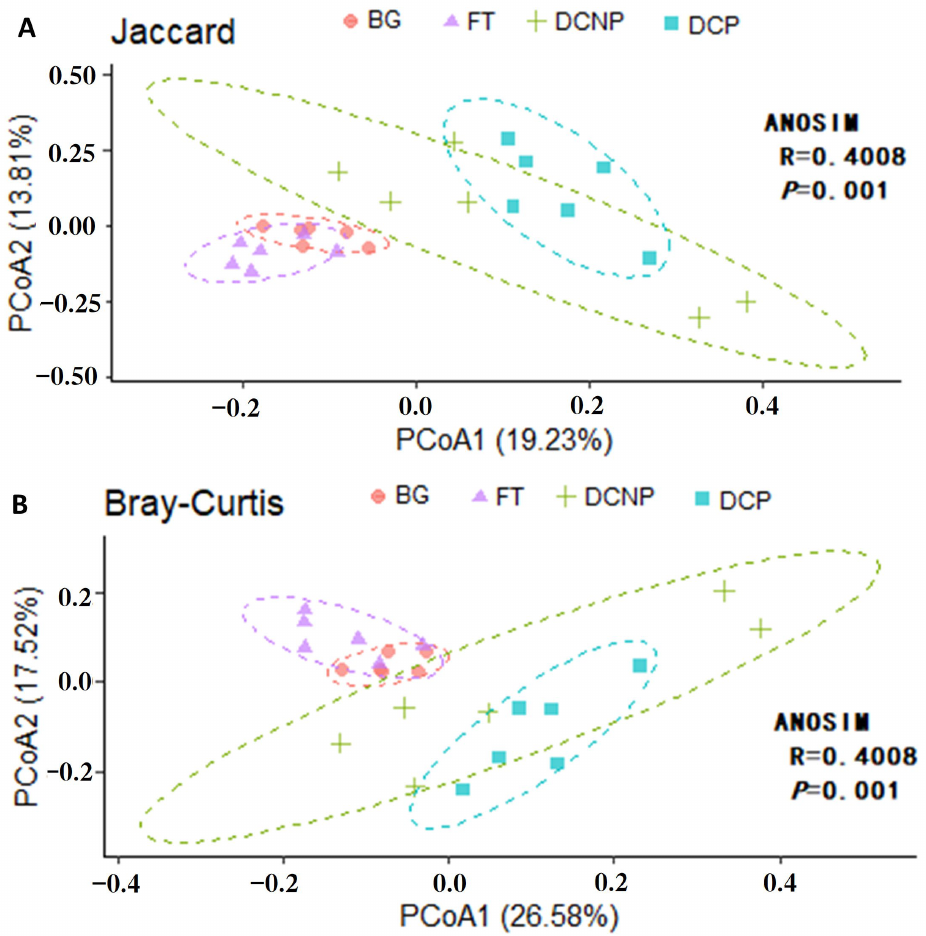
Figure 6. Principal Coordinates Analysis (PCoA) using Jaccard distance ( A ) and Bray–Curtis distance ( B ) among the four groups.